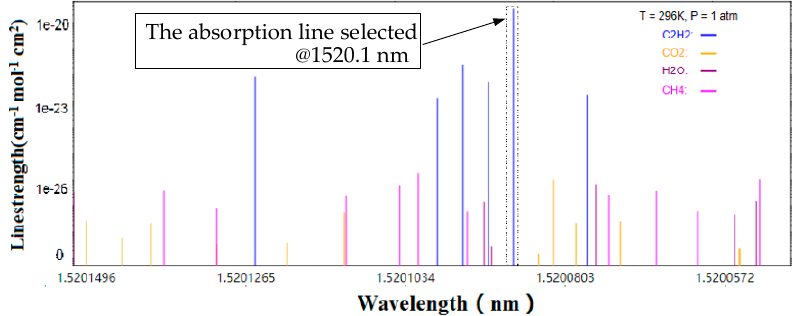
Figure 1. C 2 H 2 (blue) absorption line in the range of 1520.05–1520.15 nm. The absorption line strength of CO 2 , H 2 O, and CH 4 is much smaller than that of C 2 H 2 .